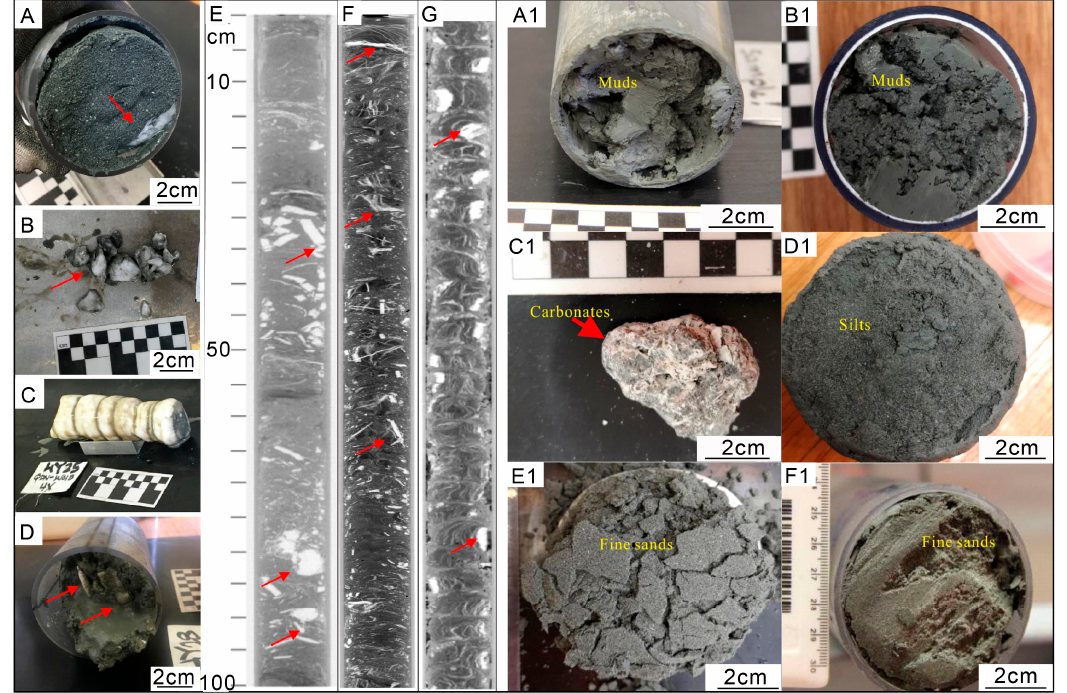
Figure 2. Shapes of the visible gas hydrate and the lithology of the Quaternary strata: ( A – D ) Gas hydrate with diverse shapes; ( E – G ) X-ray images of gas hydrate; ( A1 – F1 ) Lithology of the Quaternary strata (modified from Reference [12]). The red arrows in the subfigures ( A – G ) indicate the presence of gas hydrate with diverse shapes.